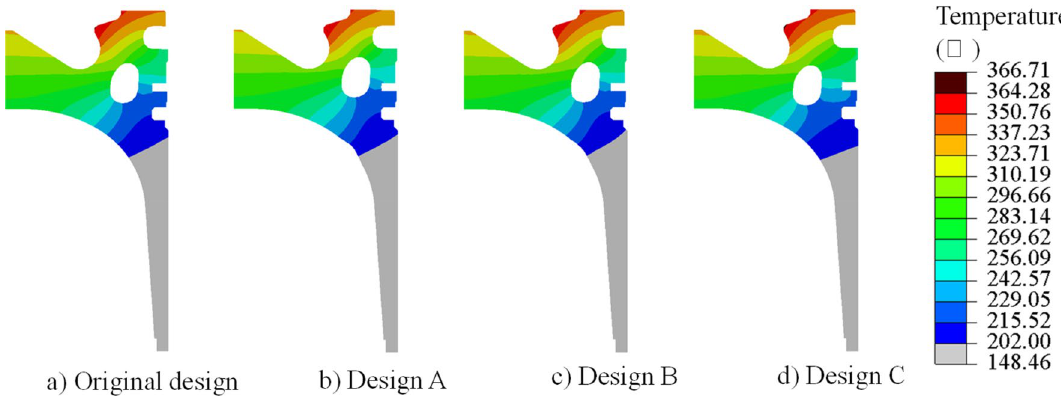
Figure 11. Temperature comparison of original design and cluster